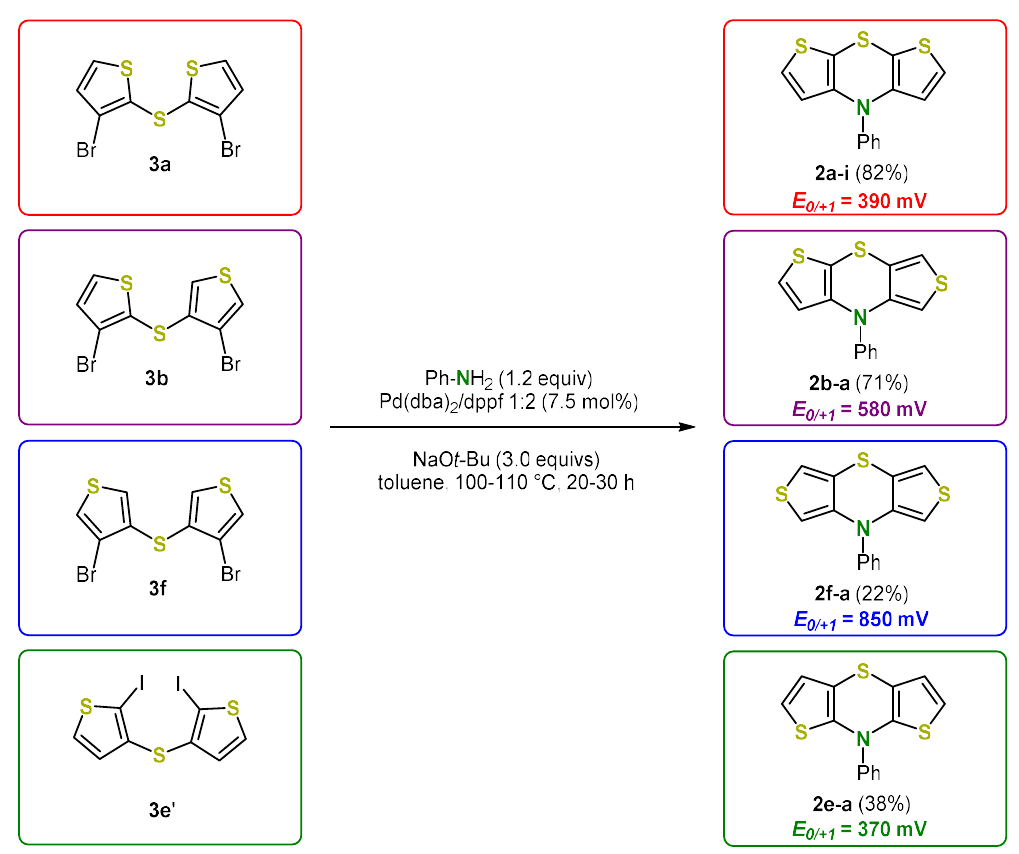
Figure 3. Synthesized dithieno[1,4]thiazine regioisomers 2 and corresponding redox potentials E 0/+1 (in CH 2 Cl 2 , T = 298 K, vs. decamethyl ferrocene) [30,35].